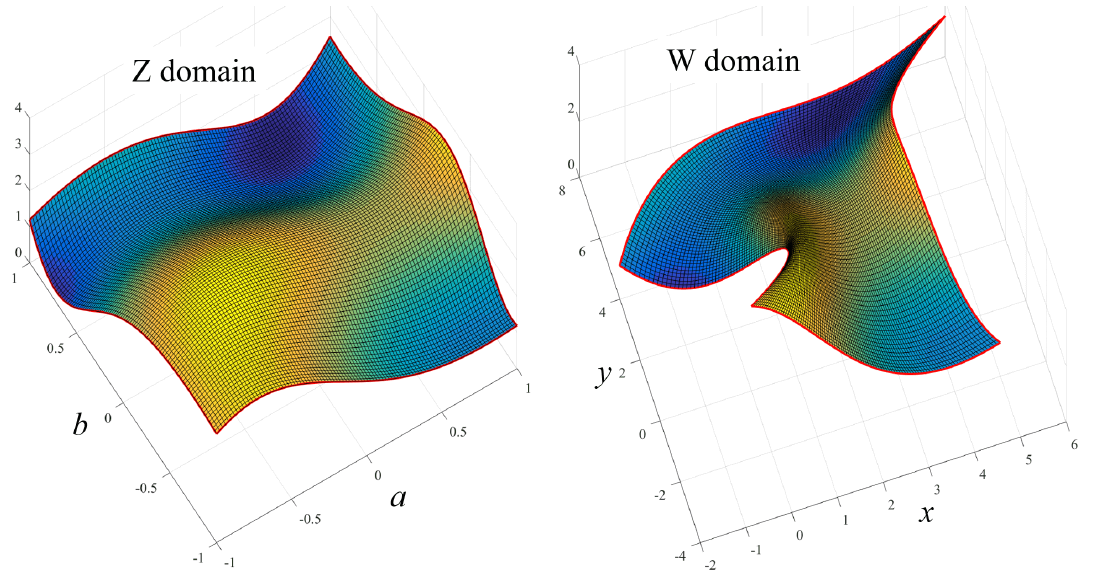
Figure 12. Example of the surfaces in the Z-domain ( left ) and in the W-domain ( right